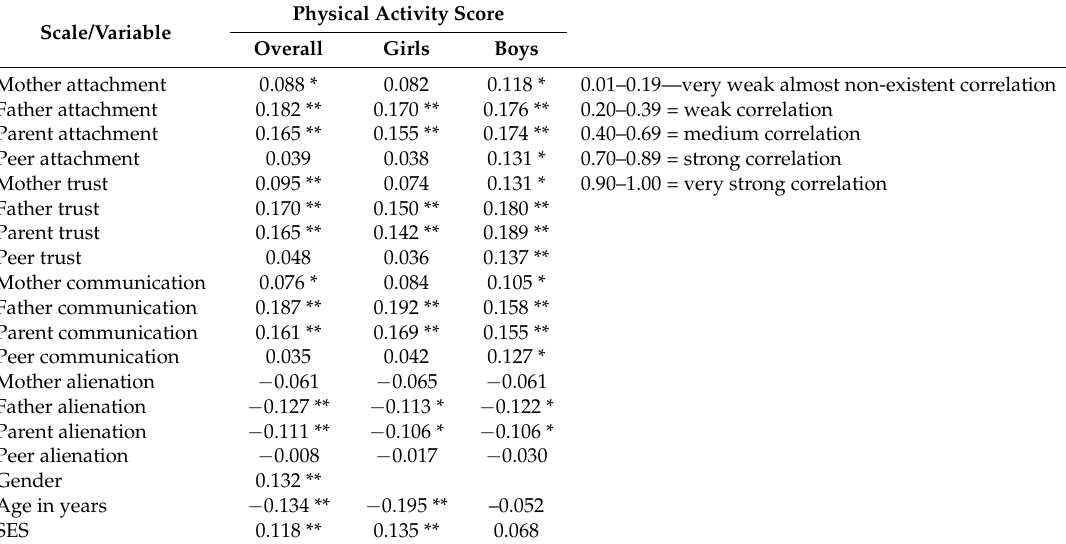
Table 3. Regression analysis coefficients with PA as a dependent